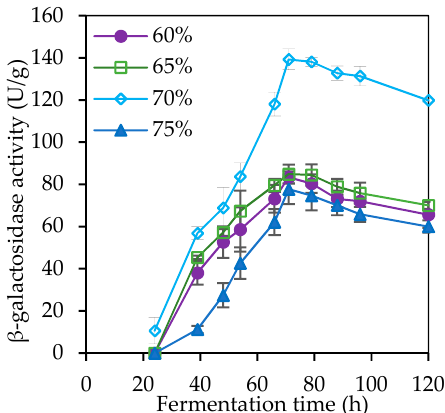
Figure 1. Effect of solid state fermentation (SSF) time in crude β -galactosidase production by A. awamori , at different initial moisture contents.